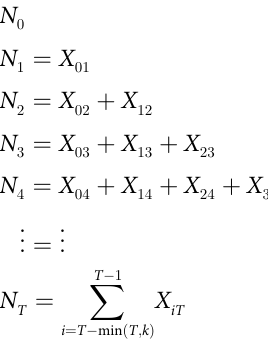
Fig 1. A precise illustration of the framework for estimating the serial interval and the instantaneous reproductive number using daily incidence time series. Step 1: Construct the likelihood function of the instantaneous reproductive number and the serial interval. Step 2: Parameterize the serial interval by known distributions. Step 3: Model the instantaneous reproductive number parametrically as a function of time using the interpolation method. Step 4: Employ the BIC and trust-region algorithm to maximize the likelihood function and tune undetermined parameters. Step 5: Use the MCMC method to estimate the target distribution of the instantaneous reproductive number and the serial interval. BIC: Bayesian information criterion; MCMC: Markov Chain Monte Carlo.